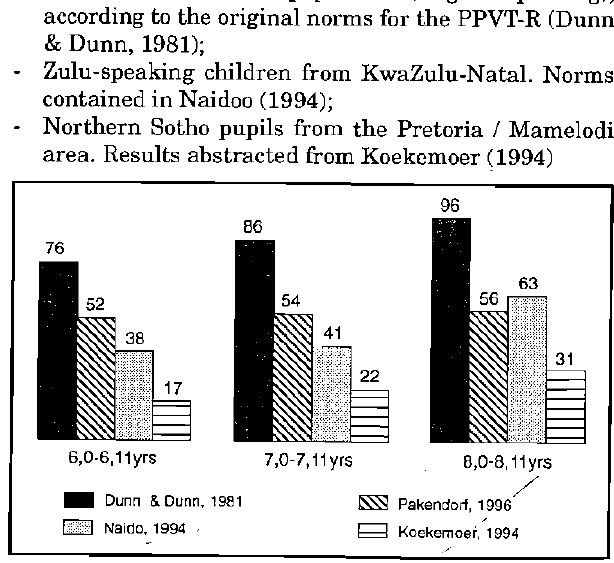
FIGURE 4: Comparison of the mean raw score for each age group involved in this study with the ex- pected mean raw scores of thre e specific popula-